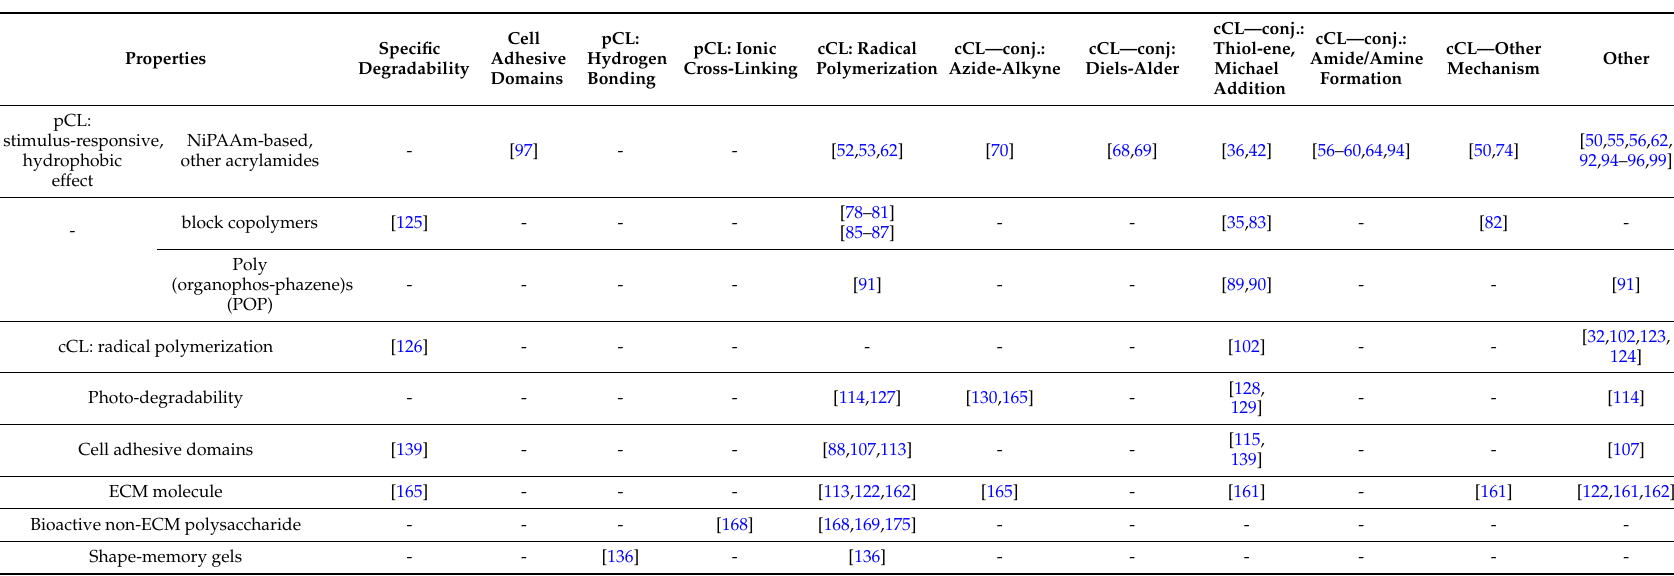
Table 2. Combinations of functional properties realized in macromers discussed in this review. pCL abbreviates physical cross-linking, cCL stands for chemical cross-linking and conj. illustrates that the corresponding functional groups allow for cross-linking via conjugation